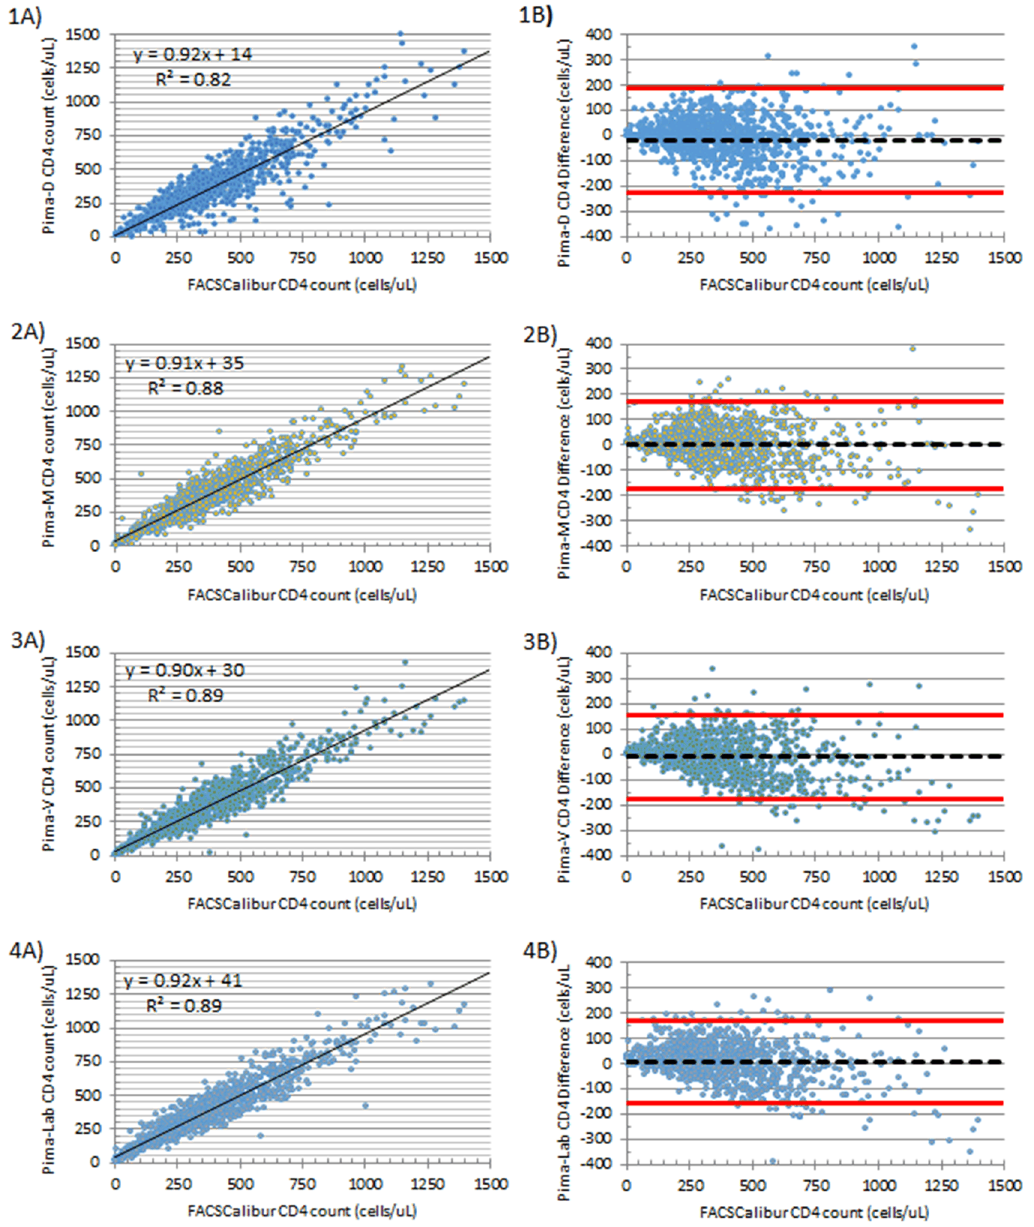
Fig 1. Scatter plots and Bland-Altman plots comparing the reference CD4 counts versus Pima CD4. Scatter and Bland- Altman plots for capillary blood directly applied to CD4 cartridges, Pima-D (1A and 1B), capillary blood collected in EDTA microtube, Pima-M (2A and 2B), venous blood,Pima-V (3A and 3B), or venous blood tested with the Pima at the reference laboratory, Pima-Lab (4A and 4B) with reference CD4 assay being BD Multitest reagent and BD Trucount Tubes using a BD